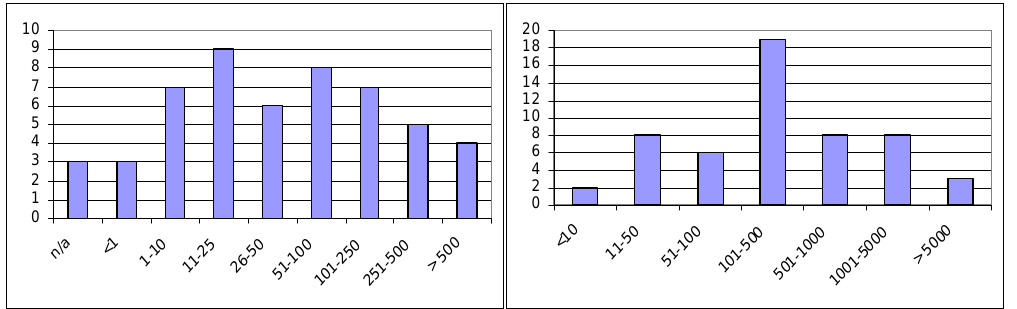
Figure 1. Histogram of turnover in (left, in million Euro) and workforce (right, in full time equivalent units) in Belgium